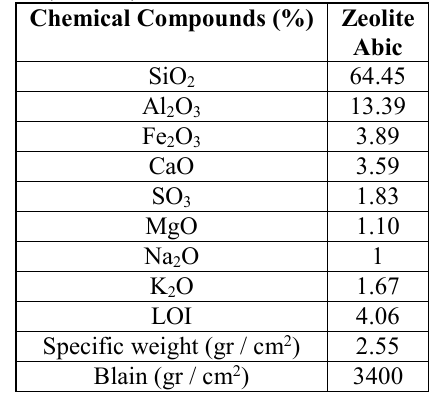
Physical and Chemical Properties of